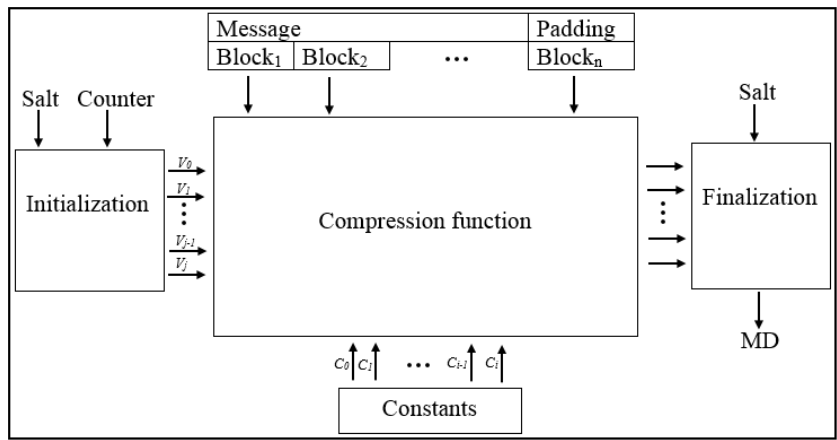
Figure 3. Architecture of BLAKE hash